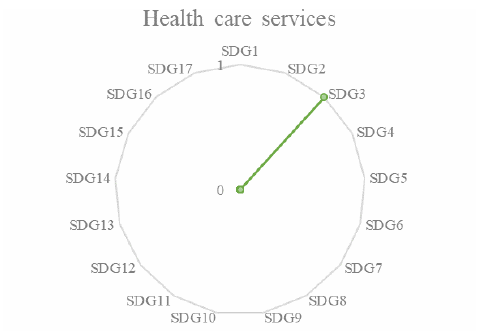
Figure 13. Health care services cluster of application effect on the